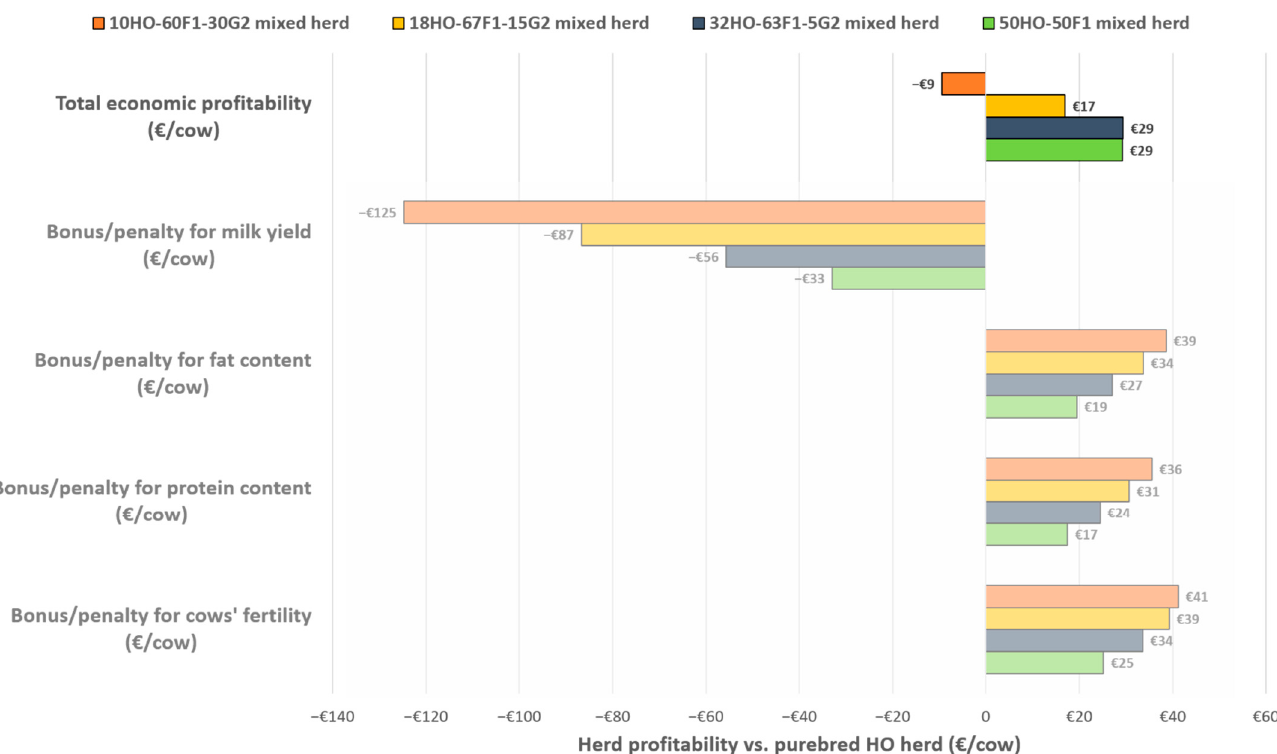
Figure 2. Differences in estimated profitability of four mixed herd compositions compared to the 100% Holstein herd in Euros/cow or Euros/1000 kg of milk. Total economic profitability for each herd was calculated as the sum of economic bonuses/penalties for milk yield, fat and protein contents and cows’ fertility.